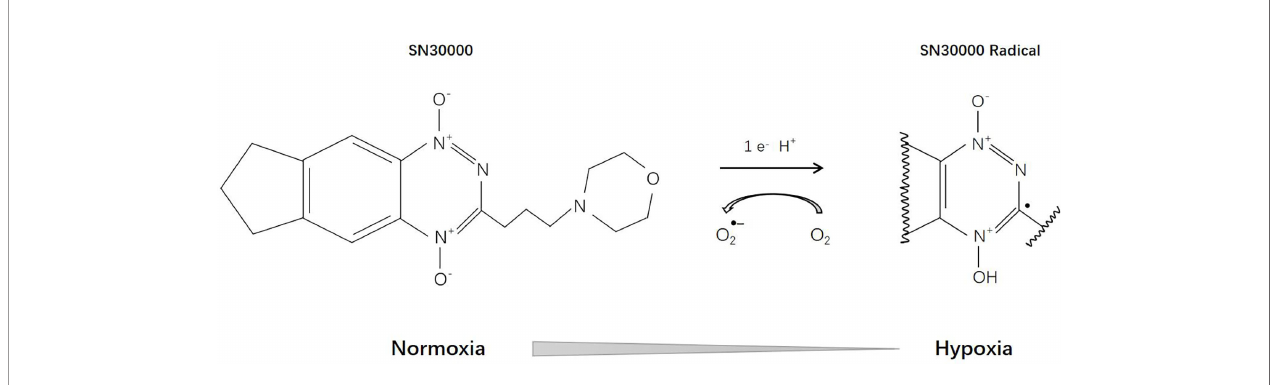
FIGURE 7 | Reductive reaction of